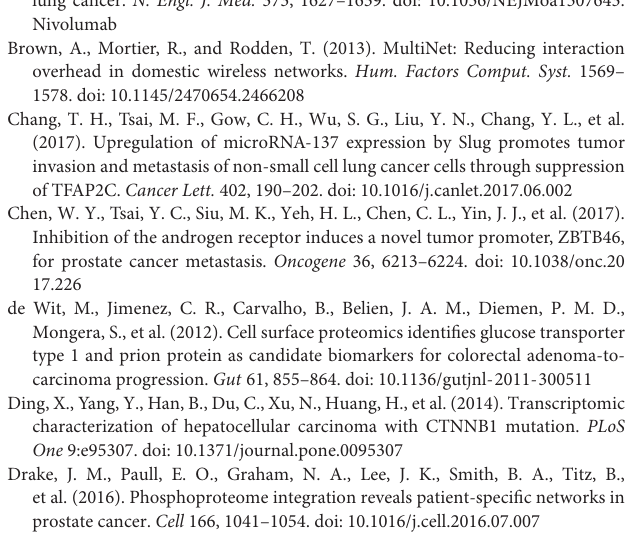
FIGURE S1 | The KM curve of 5 genes on TCGA lung cancer cohort. FIGURE S2 | The KM curve of risk index on TCGA lung cancer cohort. TABLE S1 | Identification results of membrane proteins. TABLE S2 | Different expression analysis results between high and low metastatic cell lines. TABLE S3 | Validated microRNA-regulated targets network. TABLE S4 | GO and KEGG pathway the enrichment results. TABLE S5 | Gene set enrichment analysis results. TABLE S6 | Compact subnetwork predicted by TieDIE program. TABLE S7 | cancer hallmark pathway enrichment analysis of genes involved in subnetwork. TABLE S8 | Raw clinical data and 32 membrane protein expression data on TCGA lung cancer